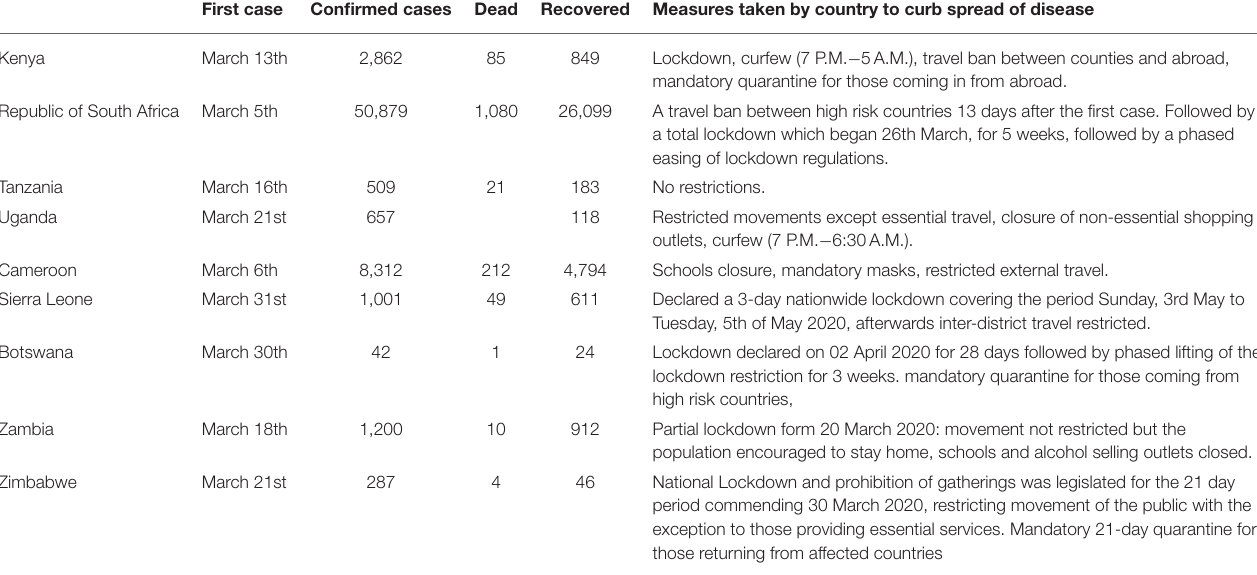
TABLE 1 | COVID-19 Country demographics as at 9th June 2020 (19). First case Confirmed cases Dead Recovered Measures taken by country to curb spread of